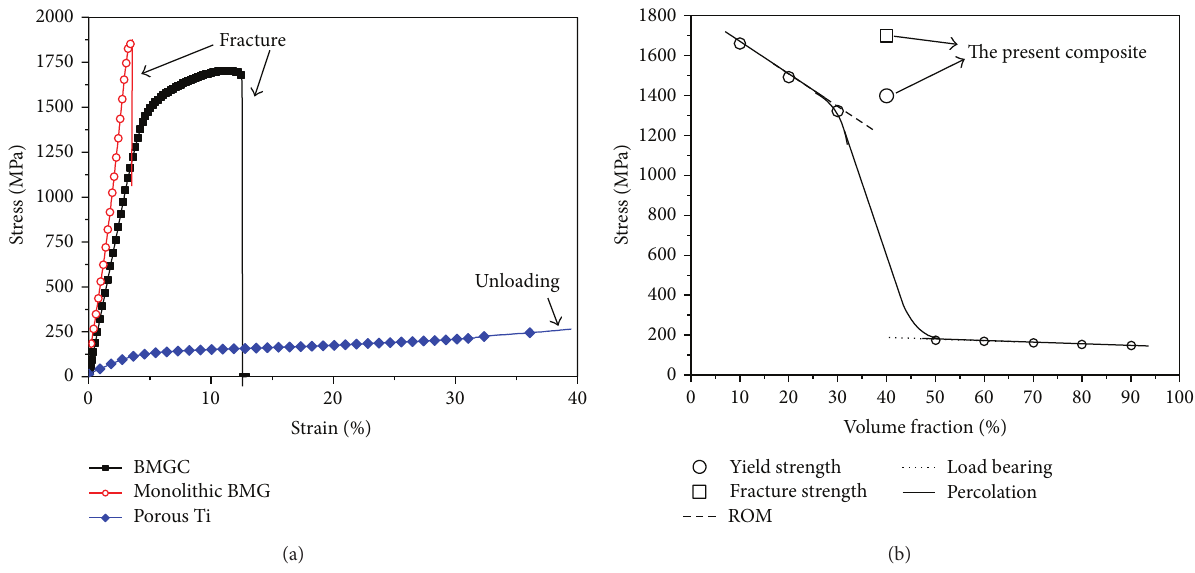
Figure 2: (a) Stress-strain curves of the monolithic BMG, porous Ti, and IPC and (b) comparison of experimental and calculated values of yield and fracture strength as a function of volume fraction for IPC. Table 1: Density ( 𝜌 ), Young modulus ( 𝐸 ), shear modulus ( 𝐺 ), yield strength ( 𝜎 𝑦 ), and fracture strength ( 𝜎 𝑓 ) of 𝛼 -Ti and monolithic BMG. 𝜌 (g/cm 3 ) 𝐸 (GPa) 𝐺 (GPa) 𝜎 𝛼 -Ti 4.51 115 44 140 ∗ 235 ∗ BMG 5.54 97.8 36.1 1830 1830 Note. ∗ The data are measured in tension